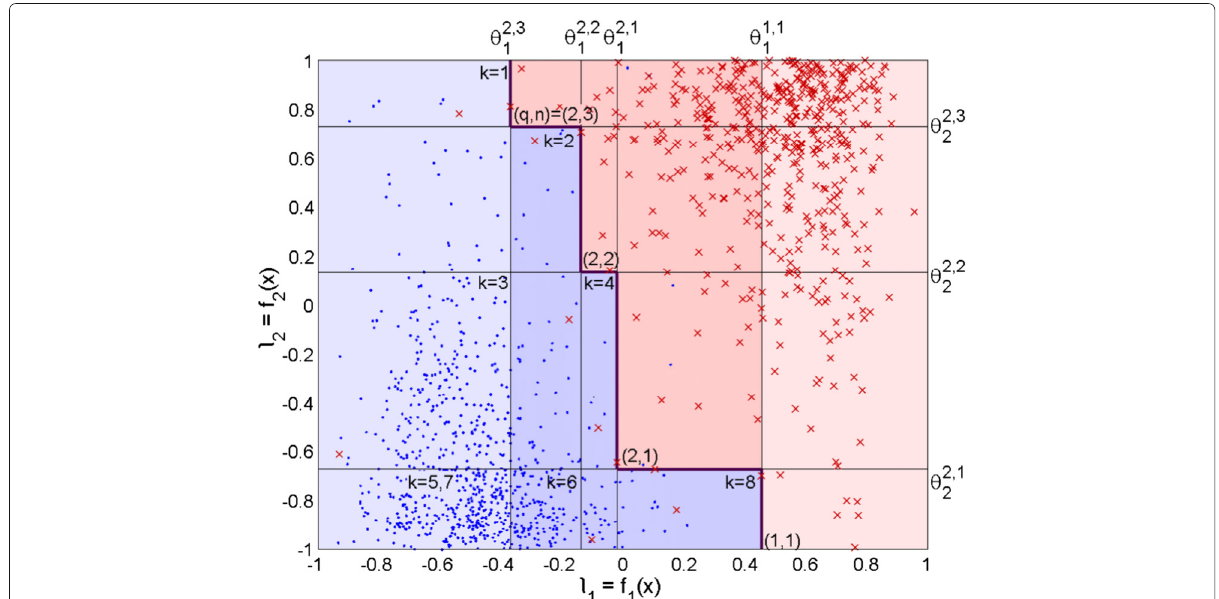
Fig. 2 Example of BOA decision boundary. Illustration of classification of MAHNOB Laughter dataset videos with BOA. Data x ∈ X = { X 0 , X 1 } from two classes, “laughter” and “speech,” is represented in terms of two target likelihood scores l 1 and l 2 . The data samples from the “laughter” class X 1 are shown with red crosses and the data samples of the “speech” class X 0 are shown with blue dots. The resulting decision boundary by the BOA combination (10) is shown with the bold angular line. Each threshold θ q , n m , m = 1,2, q = 1,2, n = 1,2,3 is illustrated with a thin line. The space of target likelihood scores where B ( x ; θ ) = true is colored with pink background, and the space where ¬ B ( x ; θ ) = true is colored with blue background. The palest background colors illustrate the subspaces, where the decision is done using the score l 1